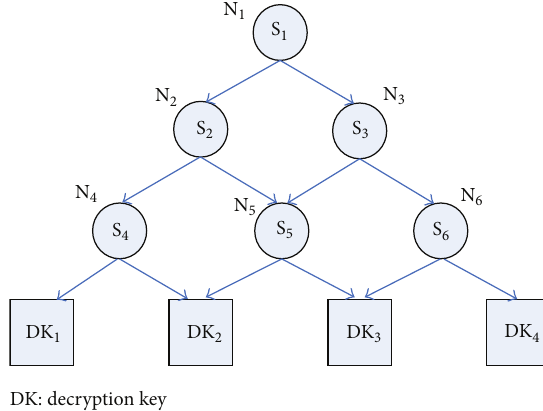
Figure 2: Hierarchical structure of key management and access